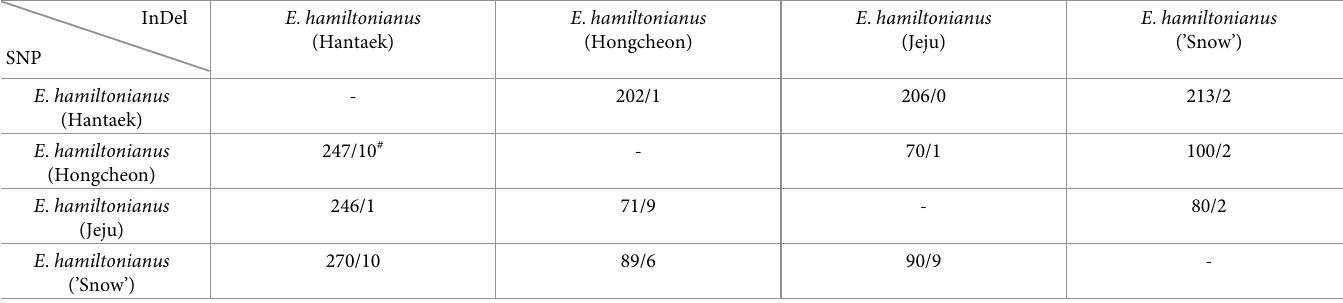
# Numbers of variations in plastomes/nrDNA are indicated for each comparison.